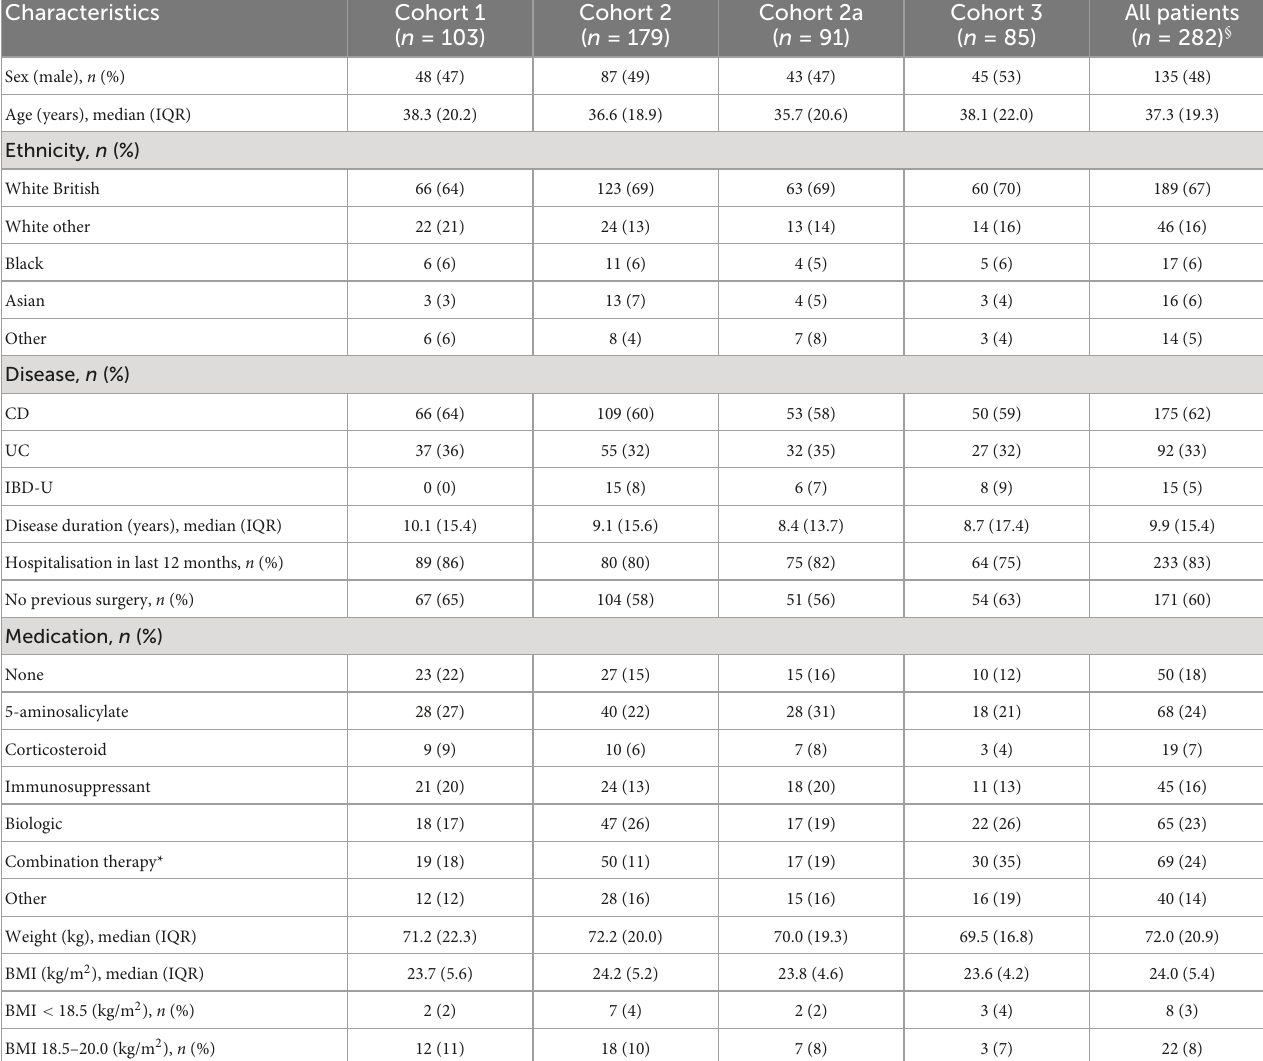
TABLE 1 Patient demographics and disease-related